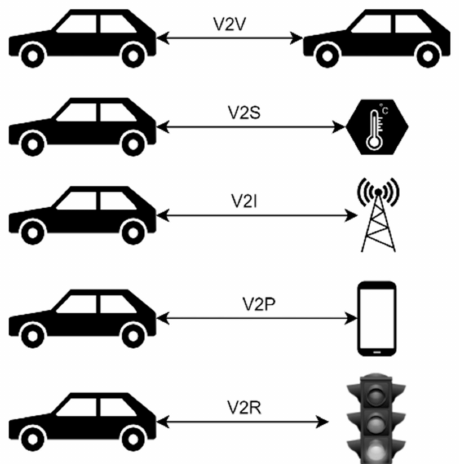
Figure 1. V2X communication modes. In order: vehicle-to-vehicle (V2V), vehicle-to-sensor (V2S), vehicle-to-infrastructure (V2I), vehicle-to-pedestrian (V2P), vehicle-to-roadside unit